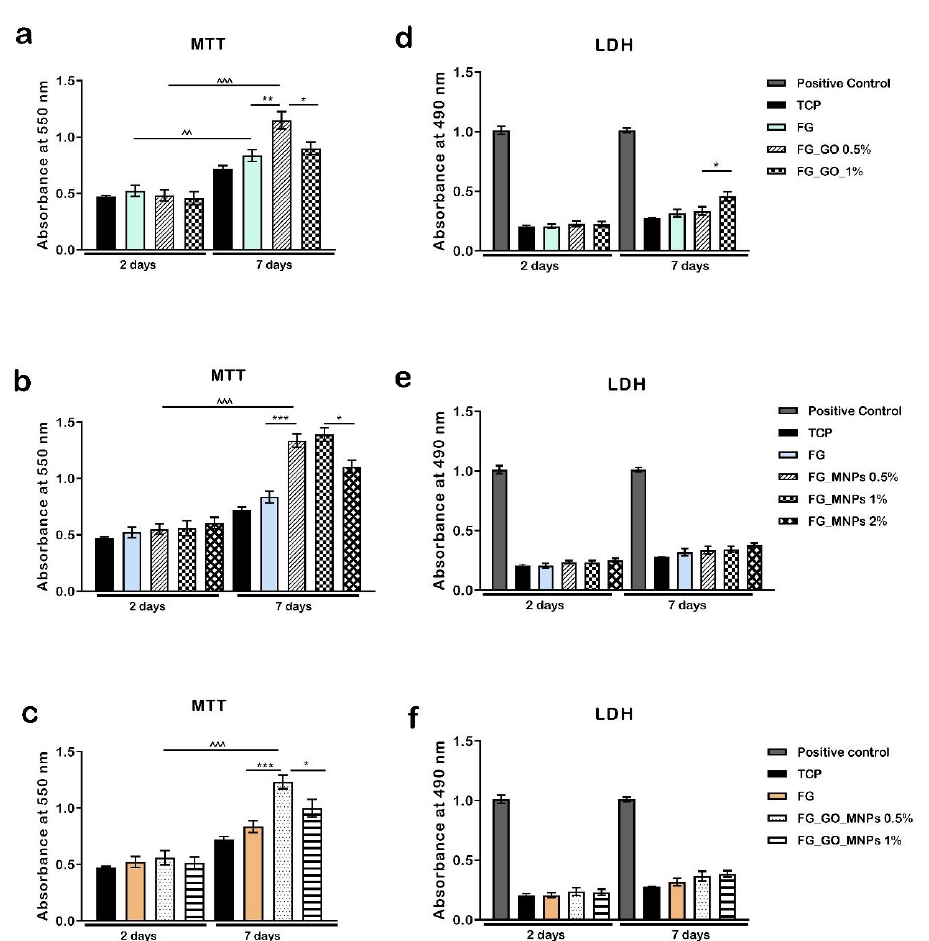
Figure 5. Biocompatibility evaluation of FG meshes in contact with mesenchymal stem cells. ( a – c ) Metabolic activity of hASCs as revealed by the MTT test during 7 days of in vitro cell culture. ( d – f ) Analysis of the materials’ toxicity by the LDH assay after one week of culture. Statistical significance : “*” symbol was used for statistical comparisons between different samples at the same time point, while “^” symbol was used to mark statistical differences between two different time points considering the same sample; * p < 0.05, ^^, ** p < 0.01, and ***, ^^^ p < 0.001. Moreover, a significant difference in the cells’ metabolic activity was registered for